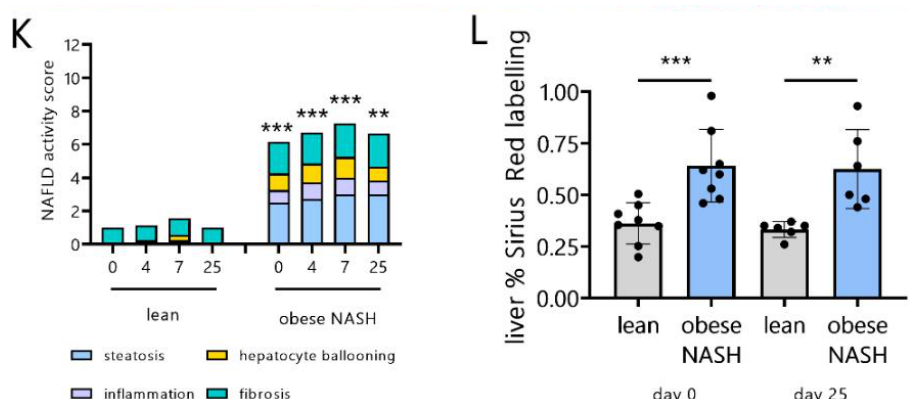
Figure 5. Effects of SARS-CoV-2 infection in terms of liver damage and fibrosis in lean hamsters vs. obese NASH hamsters. The livers of mock-infected and SARS-CoV-2-infected hamsters were collected on dpi 4, 10, and 25. ( A – F ) mRNA copy numbers were quantified by qRT-PCR. The data were expressed as the fold increase over the expression level in mock-treated lean animals. ( G – J ) Repre- sentative liver histology images after H&E staining ( G , H ) or after Sirius Red staining ( I , J ) of lean